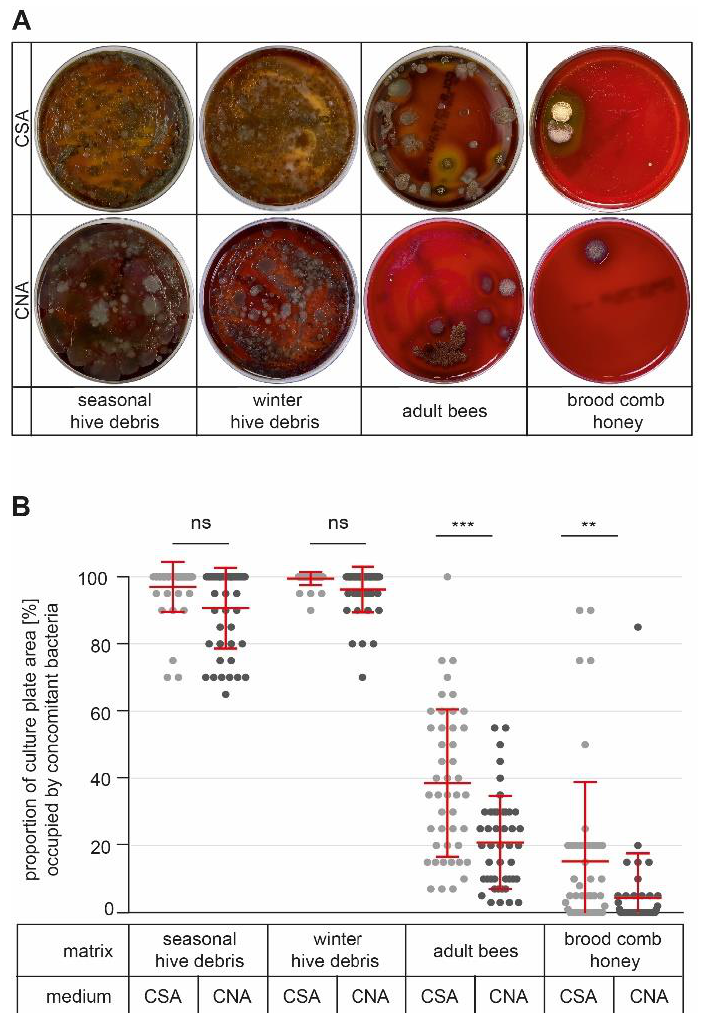
Figure 1. Presence of concomitant bacteria. ( A ) Cultivation of samples from seasonal hive debris, winter hive debris, adult bees, and brood comb honey on CSA and CNA plates always resulted in the growth of concomitant bacteria. Representative pictures from day six of cultivation are shown. ( B ) The proportion of the plate area covered by concomitant bacteria was estimated and expressed as a percentage of the entire plate area. Scatter plots show 45 samples per matrix and culture medium. In addition, mean values ± SDs of the 45 independent samples are given. Data were analyzed by Kolmogorov–Smirnov nonparametric testing (ns, p > 0.05; **, p < 0.01; ***, p < 0.001). When adult bee samples were used as matrices for P. larvae detection, growth of concomitant bacteria was markedly lower and resulted in only 38.6% ± 21.7% (CSA plates) and 20.9% ± 13.7% (CNA plates) of the plate surfaces being covered with interfering bacteria (Figure 1B). The difference in the occupied mean plate surfaces between cultivation on CSA and CNA plates was statistically significant (Kolmogorov–Smirnov test, p < 0.001), and, in addition, the number of samples with more than 50% of the plate surface occupied by concomitant bacteria decreased from 14 (on CSA plates) to 2 (on CNA plates) out of 45 (Figure